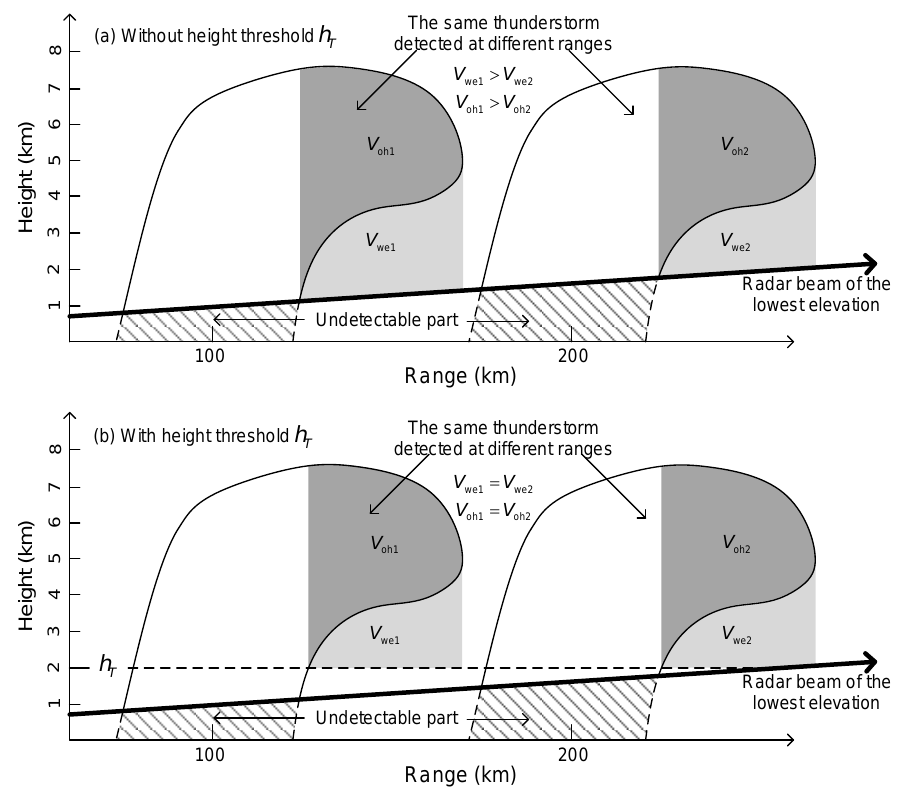
Figure 9. Schematic diagram of using height threshold h T to eliminate the influences of different minimum detectable heights on estimating